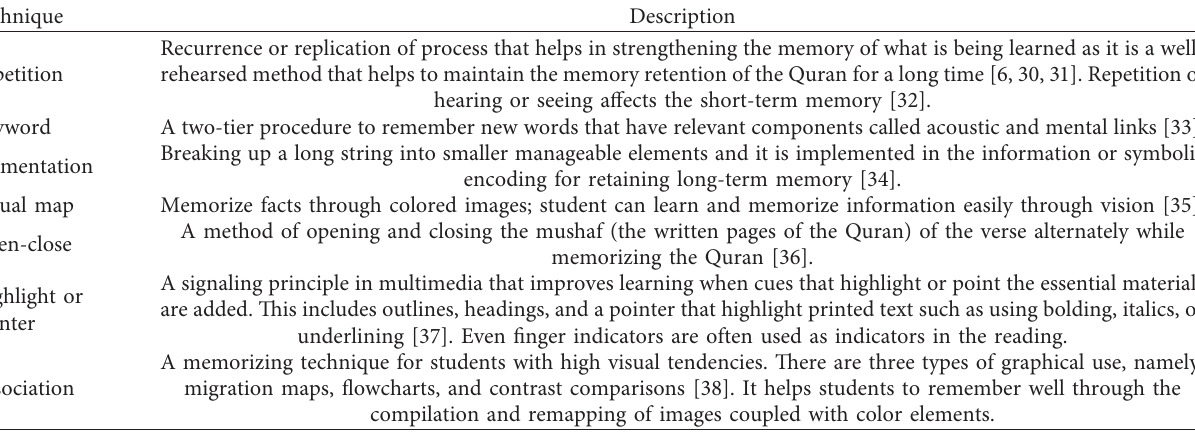
Table 1: Memorizing techniques.